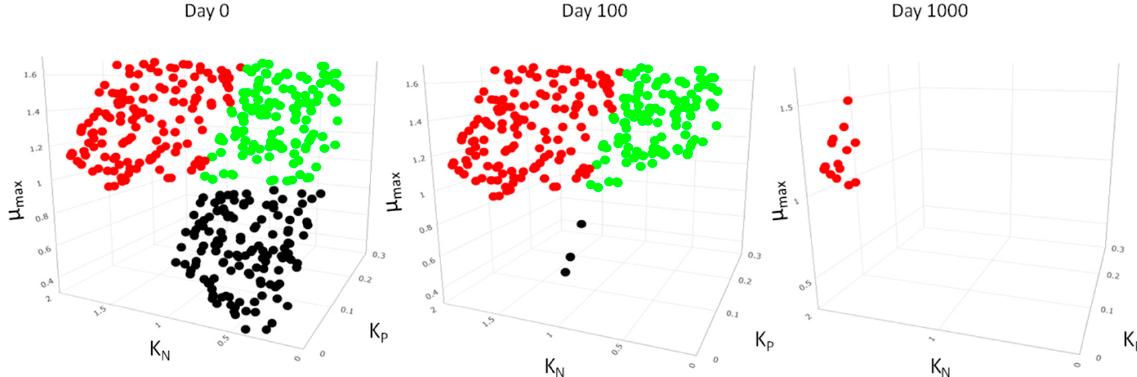
Figure 6. Three-dimensional diagram with the species life-history traits ( µ max —maximum specific growth rate, K N -half saturation constant for nitrogen, K P -half saturation constant for phosphorus) in the model at day 0 (initial species pool), day 100 and day 1000 (end of simulation). Different colors are the three groups of species based on their competitive abilities (see methods for details).